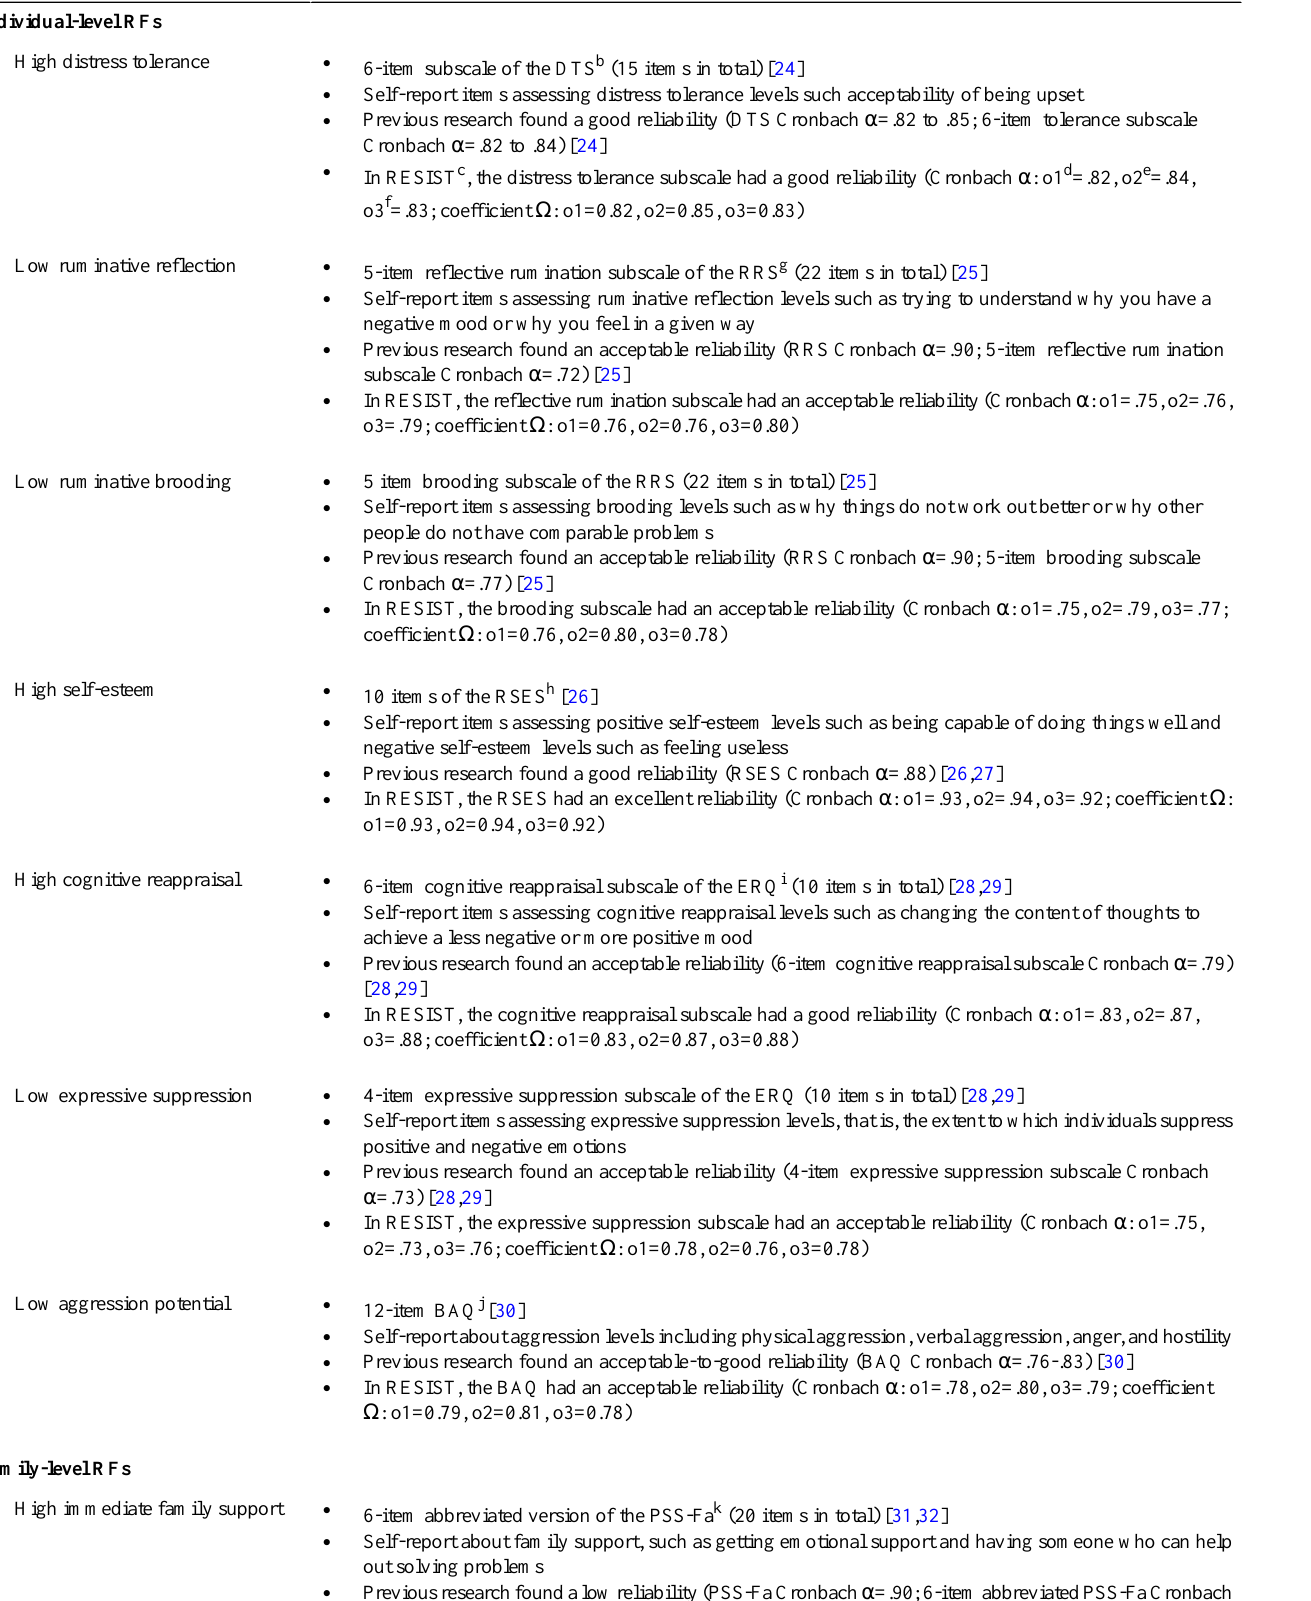
Table 2. Details of the resilience factor measures. Individual-level